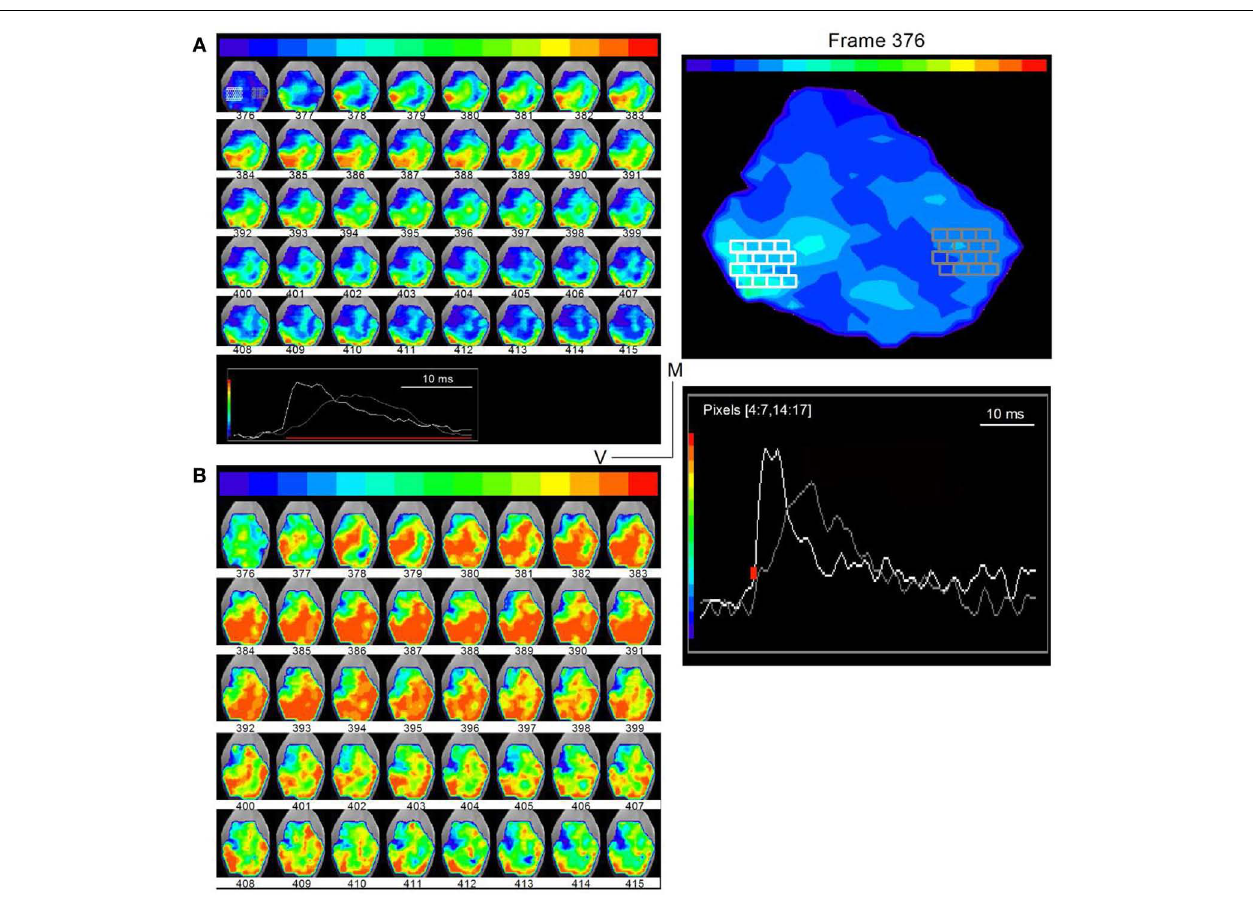
the first image (frame 376). Right panel, Expanded image of the first frame, 376, with inset traces of averaged responses in white and gray pixelated areas.The areas picked are used to illustrate different regions of the slice.The region displayed between frames 376 and 415 occur during the region of the response depicted by the red line in the inset. (B) High-gain images of the same time-lapse series show activity in directions that would correspond to cross-frequency connections.The frame sequence is the same as in (A)